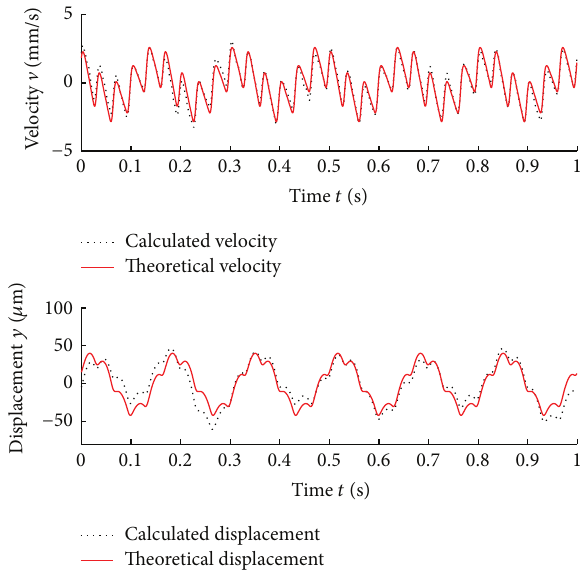
Figure4:ComparisonoftheFDIresultswiththetheoreticalsignals.